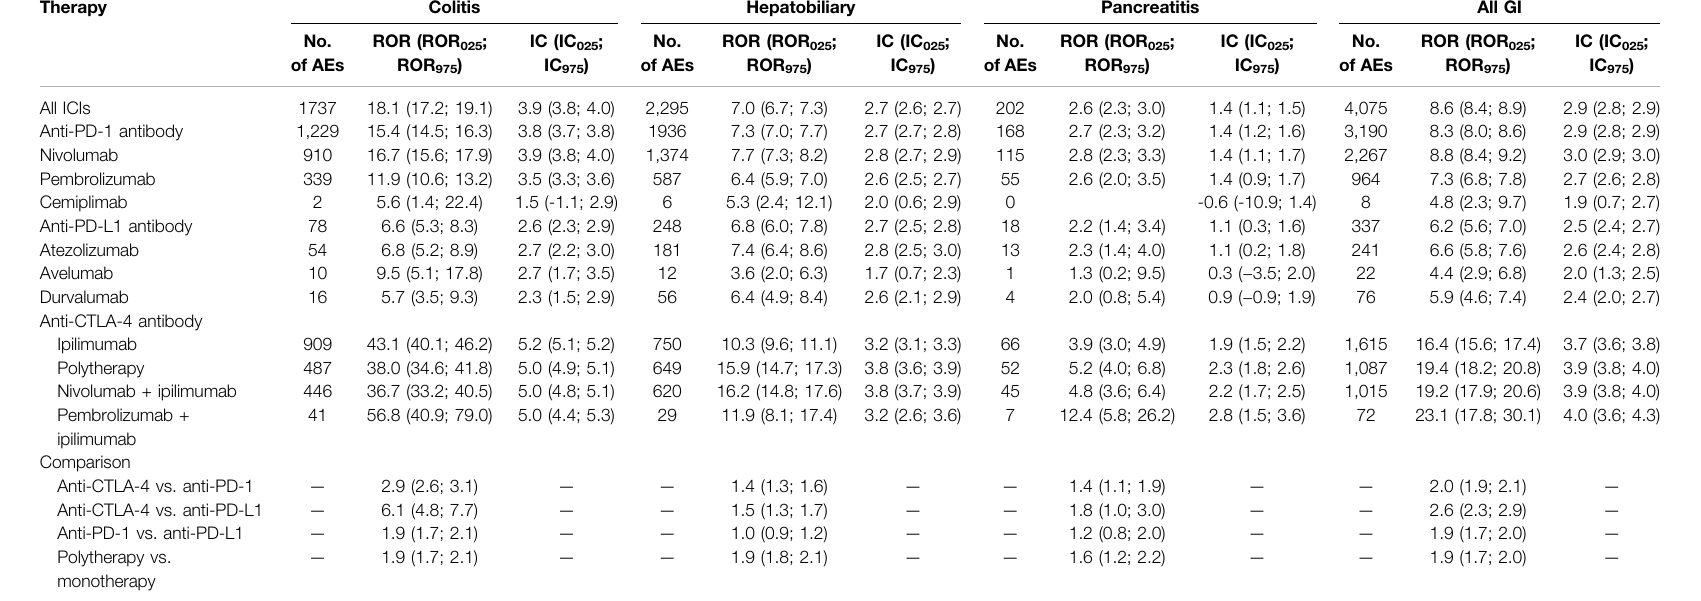
TABLE 2 | The associations of induced intestinal, hepatobiliary, and pancreatic toxicity with different ICI regimens. Therapy Colitis